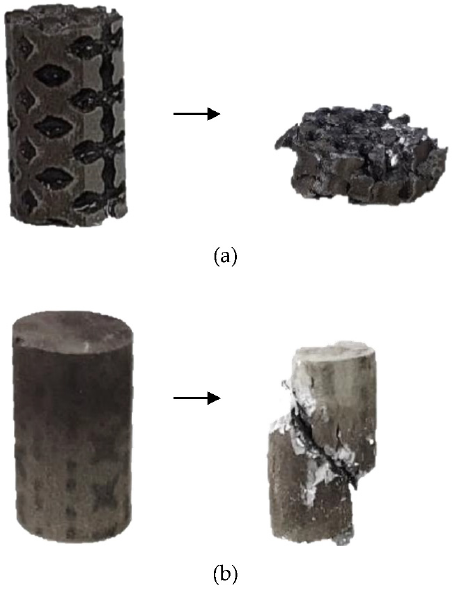
Figure 6. Typical compressive stress–strain curves of Ti–6Al–4V lattice and OI–TiZn system. The obtained results showed a repeated loss and recovery of strength by the Ti-alloy lattice that can be related to the collapsing of cells along XZ planes, as indicated by Maskery et al. [42]. In comparison, the stable strength performance of the OI–TiZn system with a naturally higher ultimate compressive strength (UCS) and yield strength compared to the Ti–base lattice is in line with the basic observations of Jiang et al. [10]. The failure mode of the Ti-base lattice shown in Figure 7a displays a layer-by-layer crushing due to shear deformation. Contrarily, the mode of failure of the OI–TiZn system (Figure 7b) was dominated by the infiltrated Zn–2%Fe alloy and resulted in pure shear fracture, while maintaining the important mechanical integrity of the OI–TiZn system. According to Jiang et al. [36], this type of fracture can be related to the critical resolved shear stress developed along the internal planes of the OI–TiZn system. Table 1. Statistical deviations of the mechanical properties under compressive loading of Ti-base lattice and OI–TiZn system.